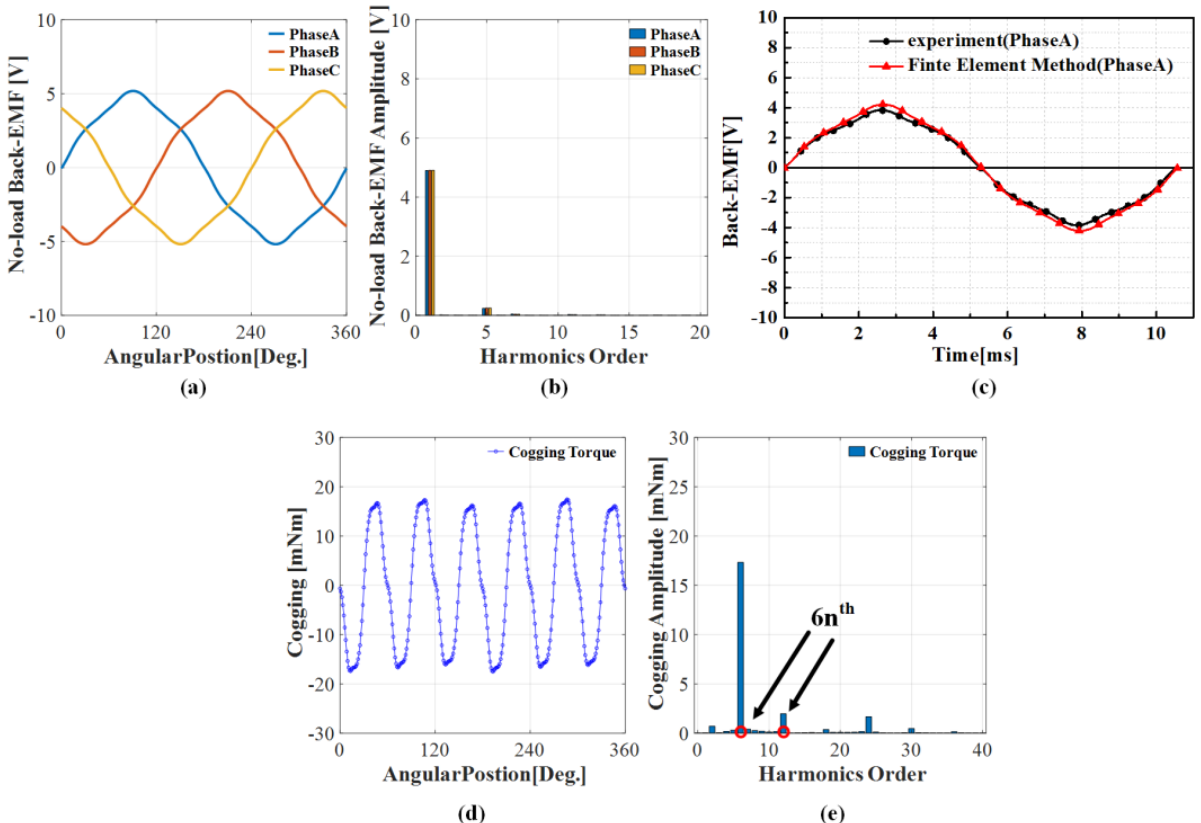
Figure 2. No-load Analysis result of no-load back EMF and Cogging Torque: ( a ) waveform of no-load back-EMF, ( b ) FFT of no-load back EMF, ( c ) experiment results of no-load back-EMF, ( d ) waveform of cogging torque, and ( e ) FFT of cogging torque.